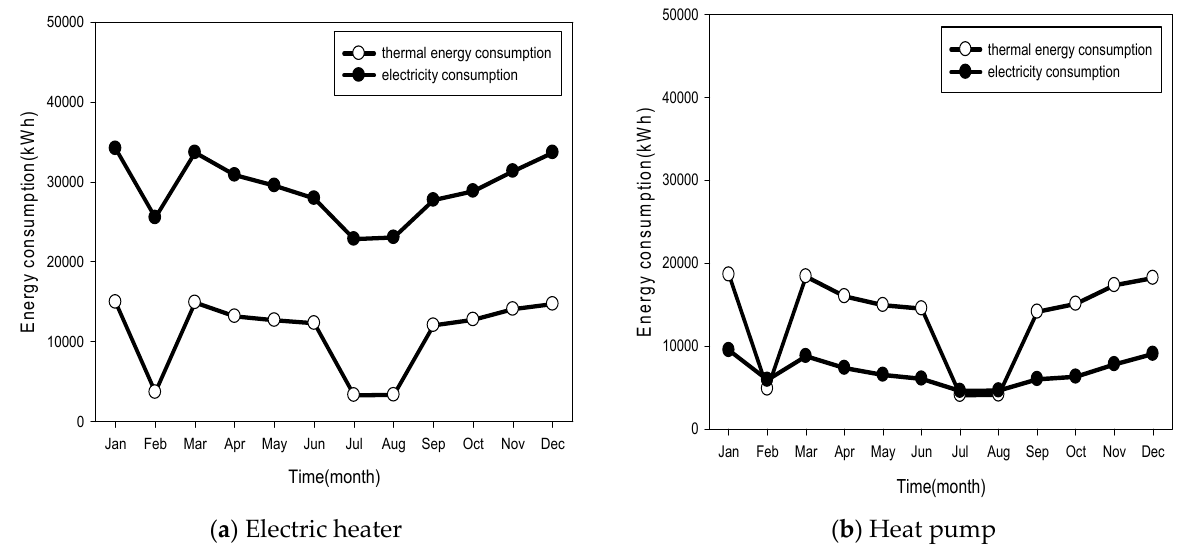
Figure 6. Heat pump water heating system.